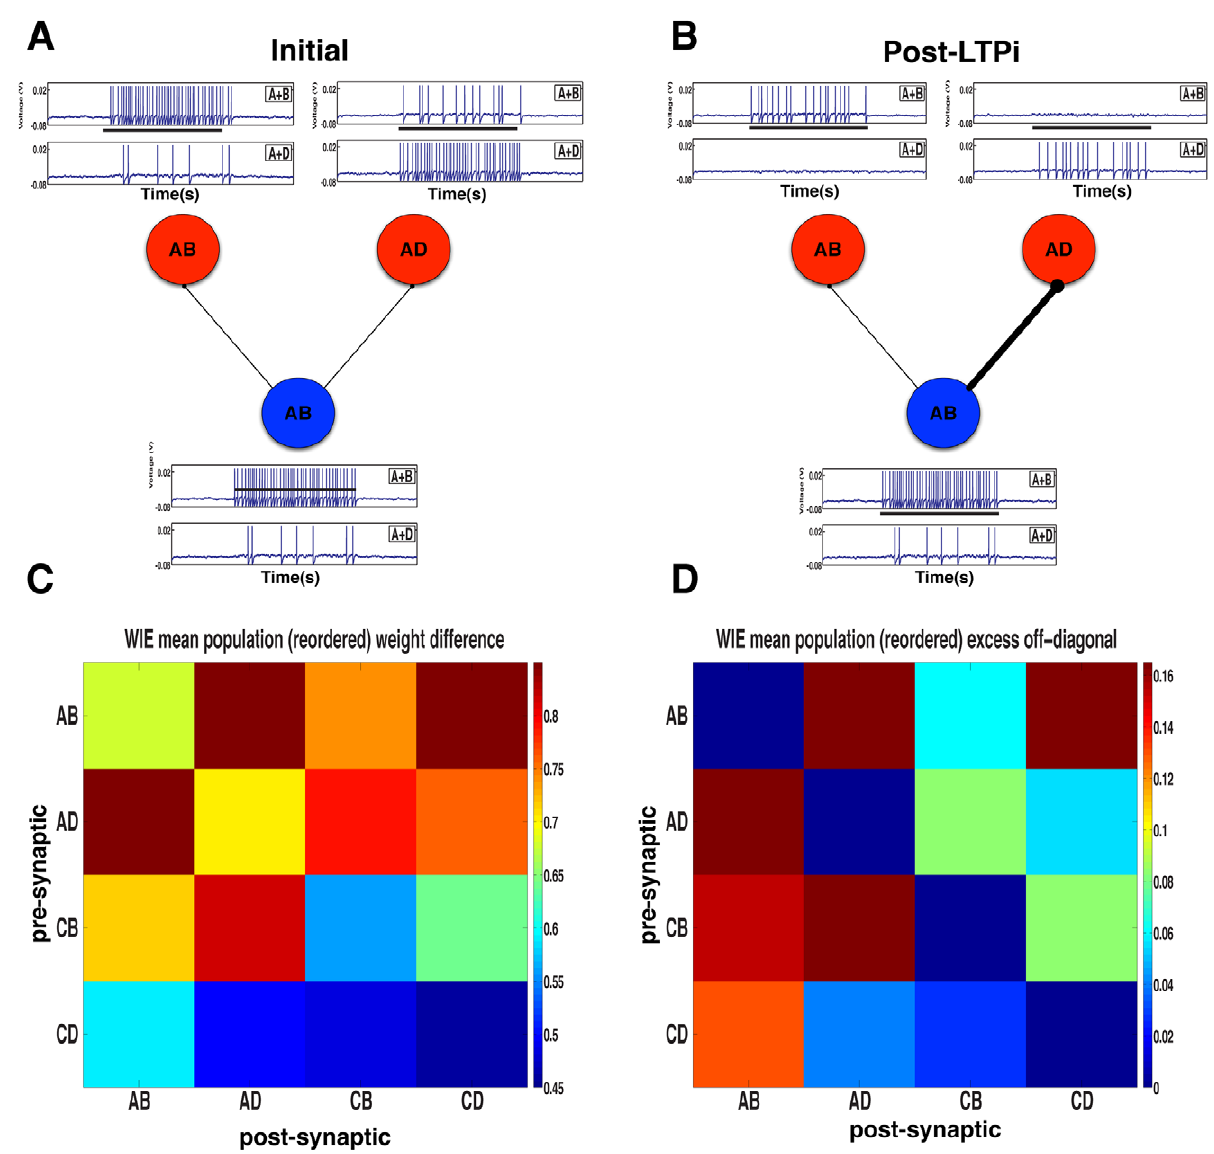
Figure 3. LTPi generates stimulus-pair selectivity via cross-inhibition. A . Initially an AB inhibitory neuron (blue) projects with equal strength to one AB and one AD excitatory neuron (red). The top voltage trace for each cell is during an A + B trial, while the lower voltage trace is during an A + D trial (The black bar underneath the figure represents cue presentation time of 1 s). B . Synaptic strength from the AB inhibitory neuron to the AD excitatory neuron increases substantially following training, as the excitatory AD cell rarely fires during the A + B stimulus-pair to veto, via coincident firing, the LTPi arising from inhibitory spikes. Meanwhile, synaptic strength from the AB inhibitory neuron increases by only a small margin to the AB excitatory cell due to the large number of vetoes of LTPi produced by coincident excitatory and inhibitory spikes as they share inputs A + B. C . The change in synaptic weight at the inhibitory-to-excitatory synapse is shown by the magnitude of change from the initial weights. The stronger synapses are from inhibitory to excitatory neurons that share the least inputs off the diagonal, i.e. cross-inhibition. Excitatory neurons that share the same input have the weakest inhibitory presynaptic connections due to the strongest veto effect. D . We illustrate cross-inhibition by LTPi, by taking the weight changes between groups (shown in C) and subtracting the within-group value (the diagonal) for each presynaptic cell (each row). Inhibition is visibly strongest off diagonal (cross-inhibition) while weakest along the diagonal (self-inhibition) for similarly responsive inhibitory and excitatory